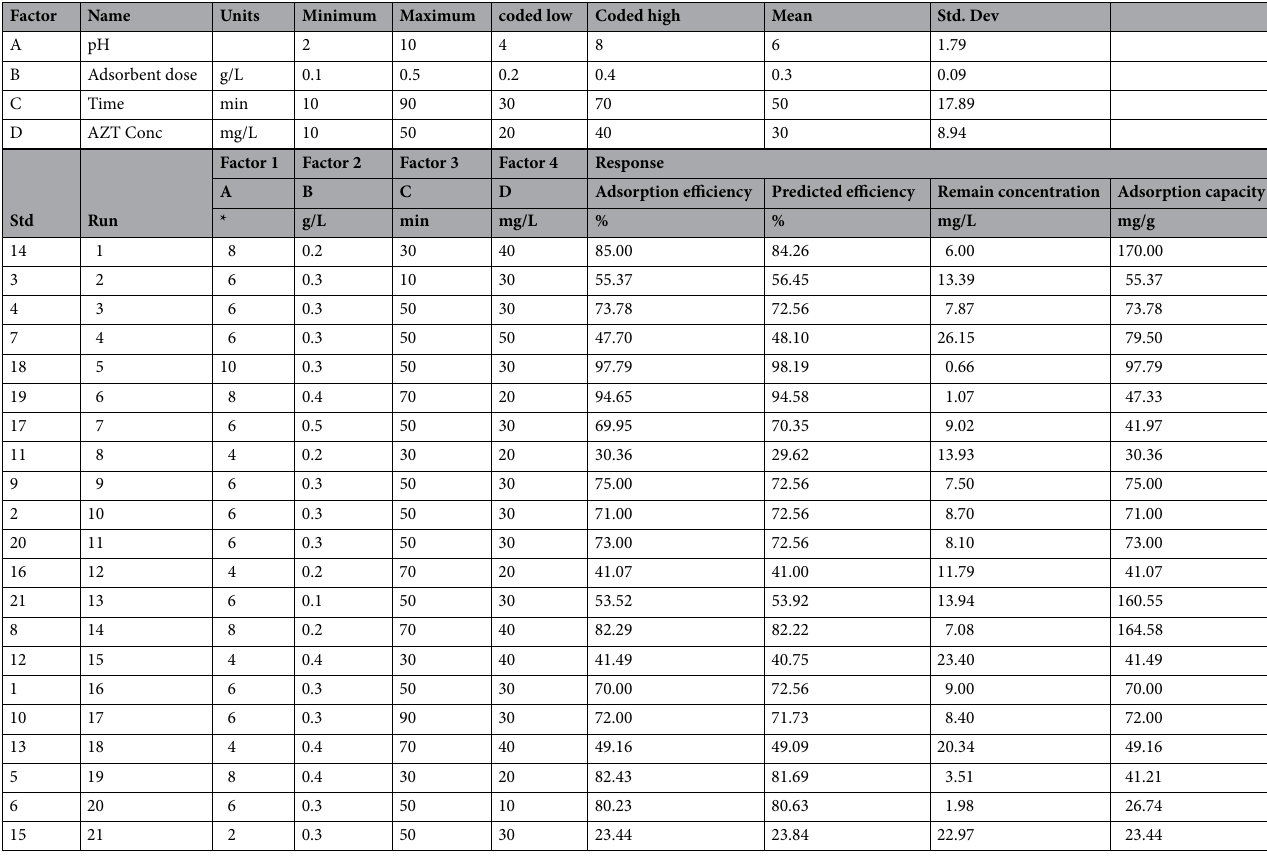
Table 1. CCD matrix ranges and their response for adsorption of AZT by MIL/Cs@Fe 3 O 4